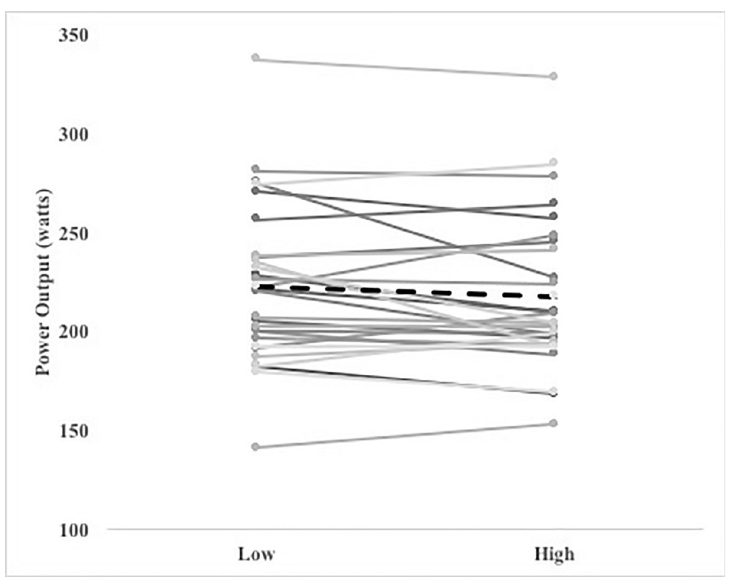
Fig 1. Power output (watts) profile. Power output for each participant and condition during the 20’ self-paced exercise. Dashed line represents the overall mean.